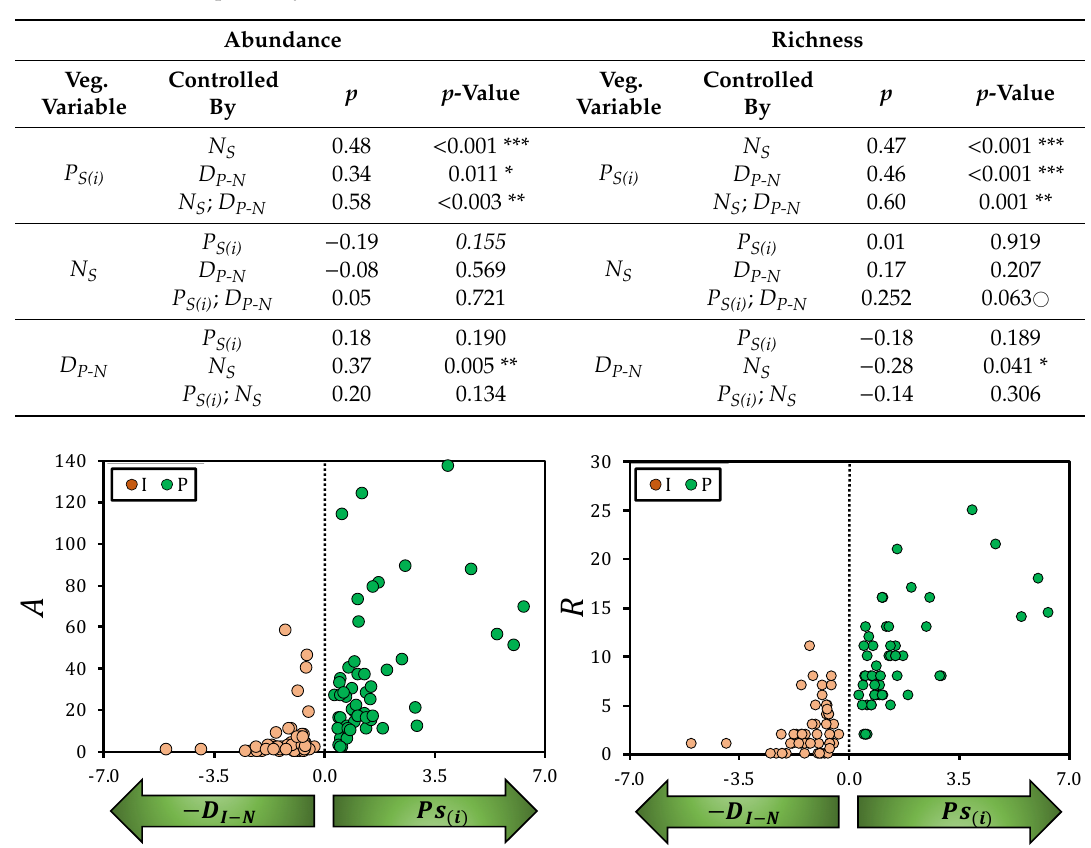
Table 3. Partial correlation coe ffi cients ( p ) and p -values for the relationships between spatial pattern descriptors and species richness and abundances of ground arthropods found in vegetation patches.